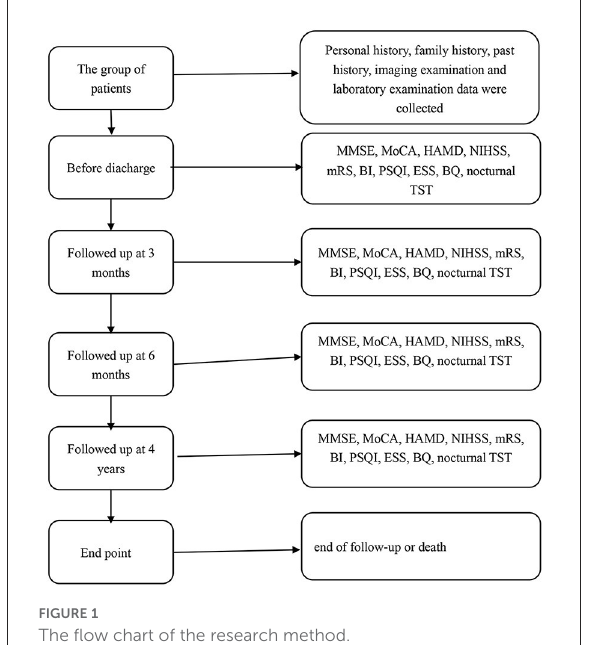
FIGURE1 The flow chart of the research